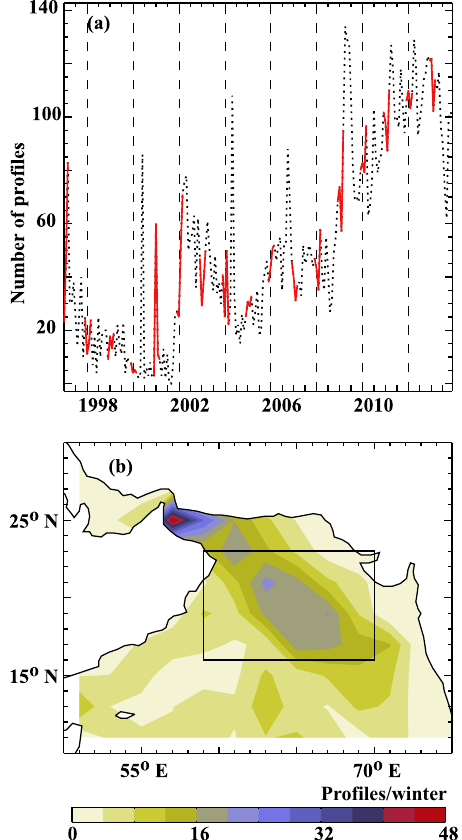
Figure 2. (a) Time series of the number of in situ profiles per month over the NAS box, from 1997 to 2013. The curve is highlighted in red for winter (DJFM). (b) Average winter in situ profile density (per 2 ◦ × 2 ◦ box and per season) for 2002–2012. The NAS region is indicated by a black frame in (b)